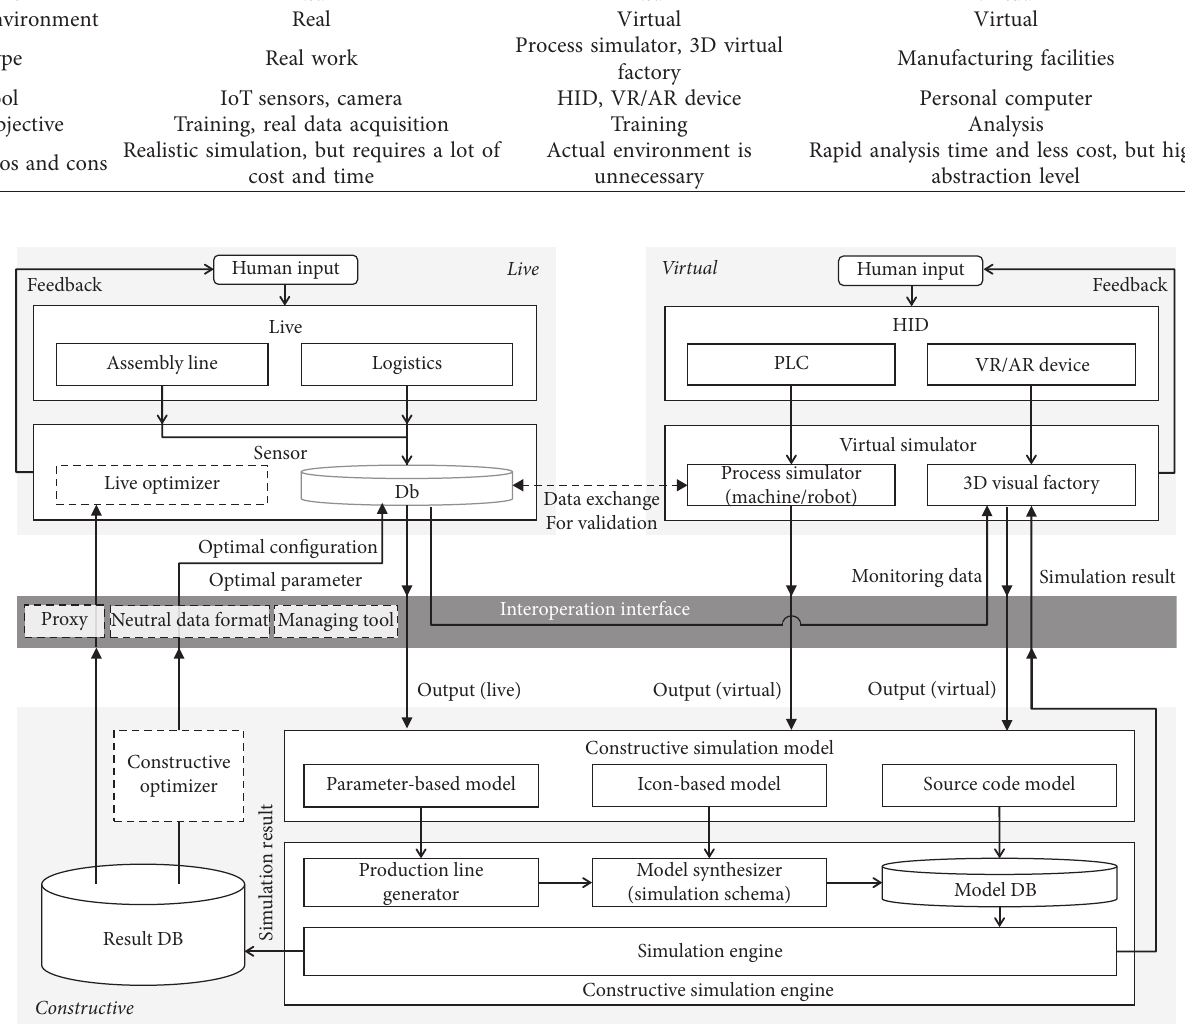
Figure 8: Overall architecture of LVC interoperation in smart